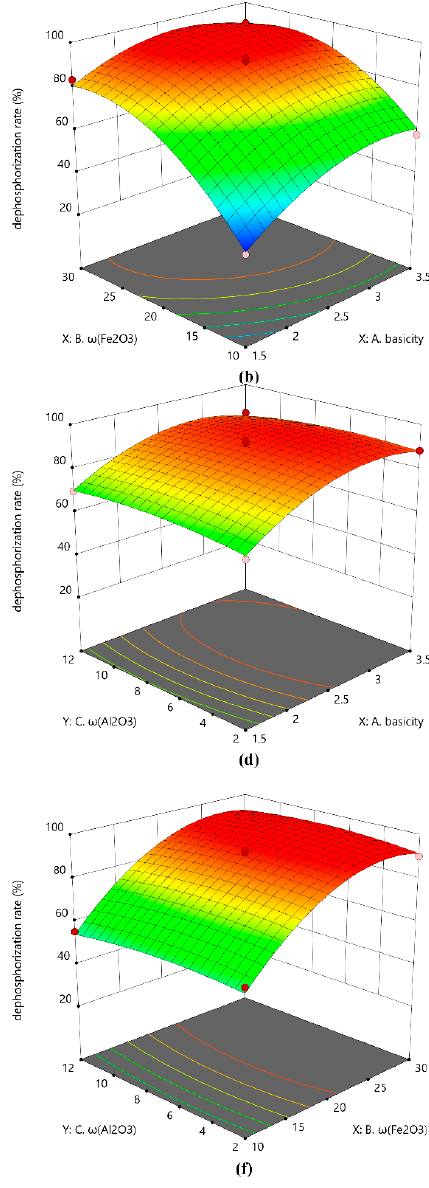
Figure 11. Contour plot and 3D response surface plot of each two-factor interaction. ( a ) contour plot of basicity and ω (Fe 2 O 3 ); ( b ) 3D response surface plot of basicity and ω (Fe 2 O 3 ); ( c ) contour plot of basicity and ω (Al 2 O 3 ); ( d ) 3D response surface plot of basicity and ω (Al 2 O 3 ); ( e ) contour plot of ω (Fe 2 O 3 ) and ω (Al 2 O 3 ); ( f ) 3D response surface plot of ω (Fe 2 O 3 ) and ω (Al 2 O 3 ). It can